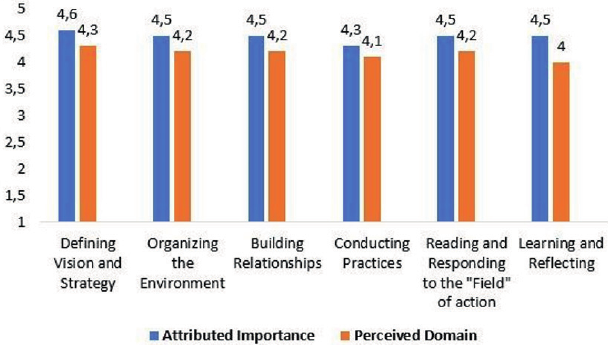
Figure 5. Attributed importance and perceived domain about the competences of racket sports coaches (part